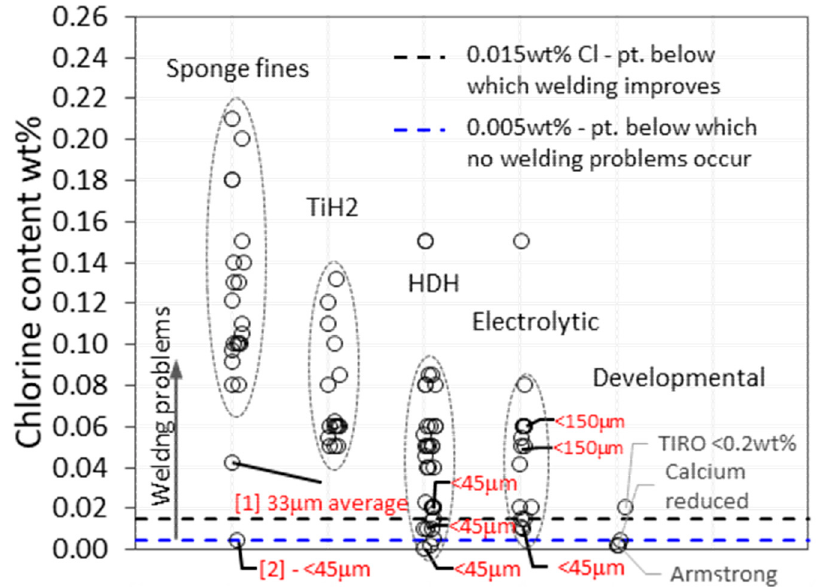
Figure 3. Chlorine content of various titanium powders. Data from literature and direct powder quotations (41 sources). Powder particle sizes labeled in red.